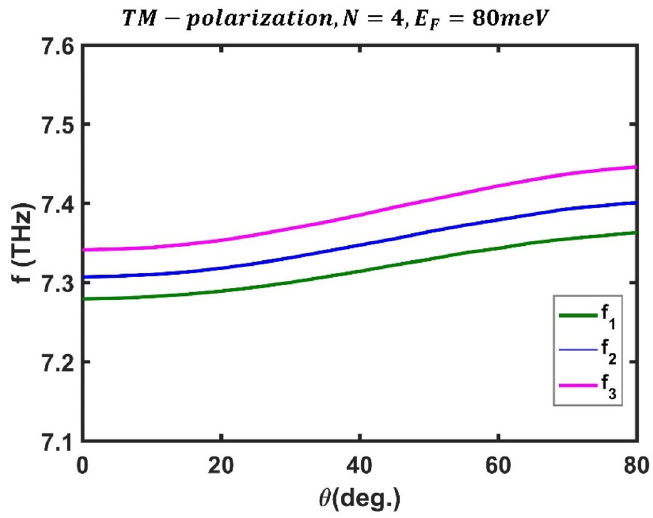
Figure 12. Dependence of central frequency of all three optical channels on the light incident angle for TM polarization state in third-order F-1D PhC structure at fixed values of E F = 80 meV and N = 4 . The central frequencies of all three optical channels are shown in green, blue and magenta colors and changes from ( f